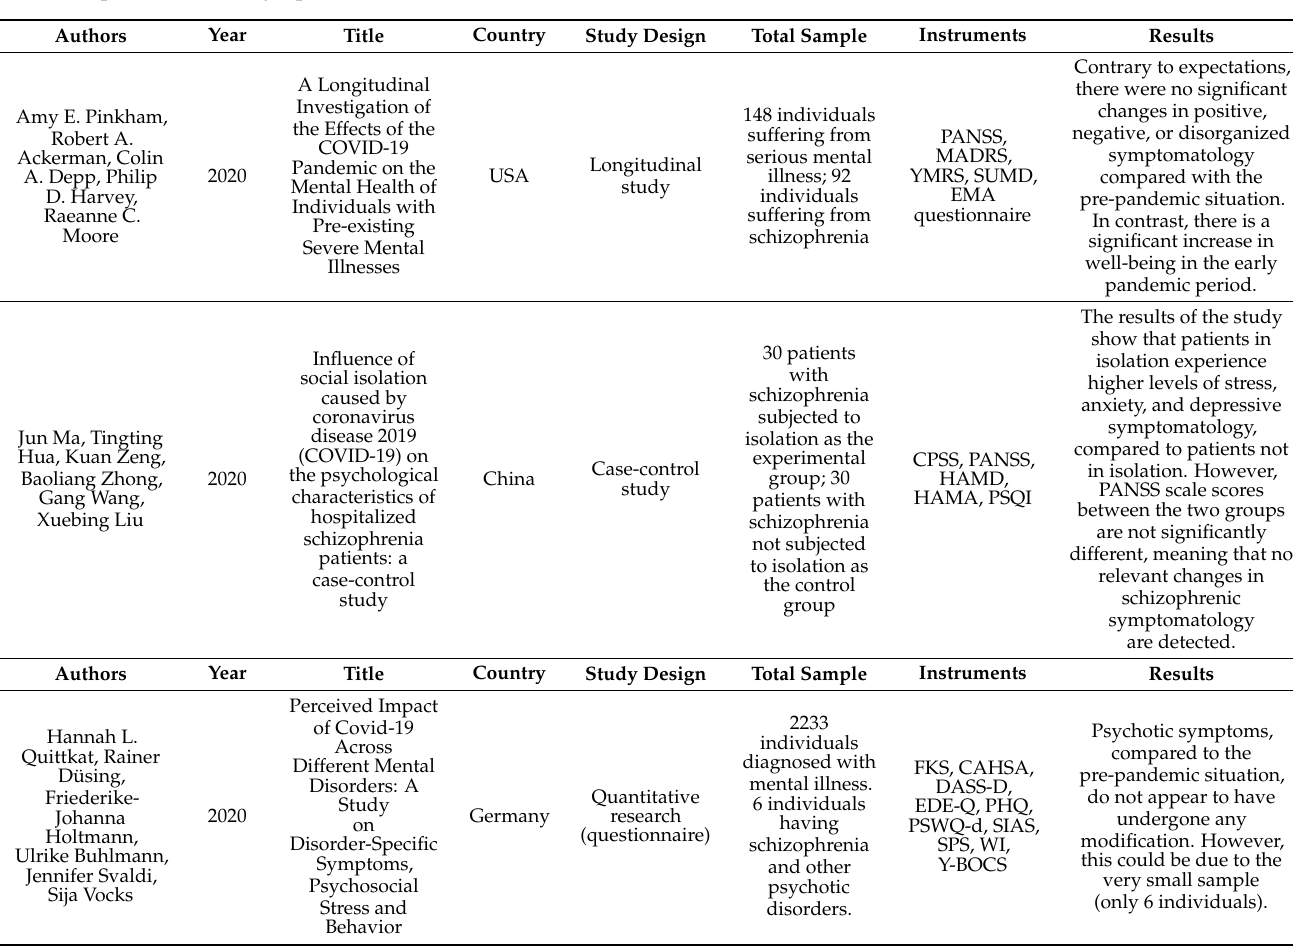
Table 1. Articles included in the review. Legend: PANSS = The Positive and Negative Syndrome Scale; MADRS = Montgomery–Asberg Depression-Rating Scale; YMRS = Young Mania Rating Scale; SUMD = Scale to